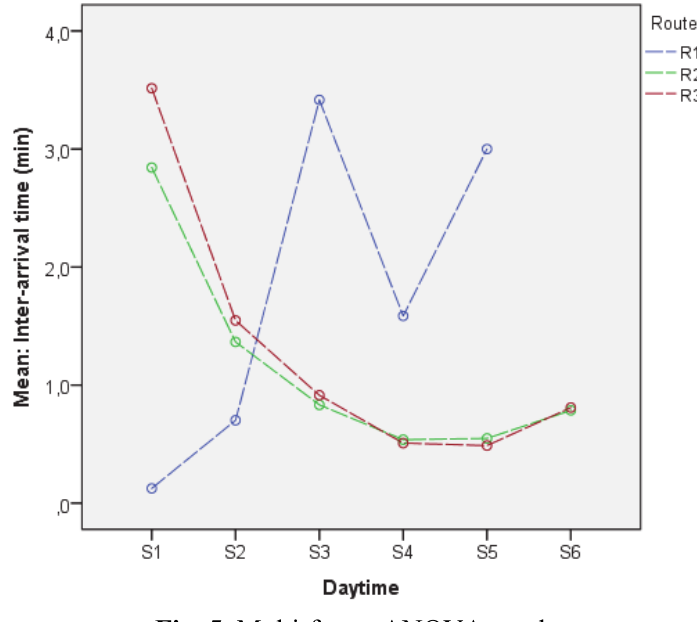
Fig. 5 . Multi-factor ANOVA results